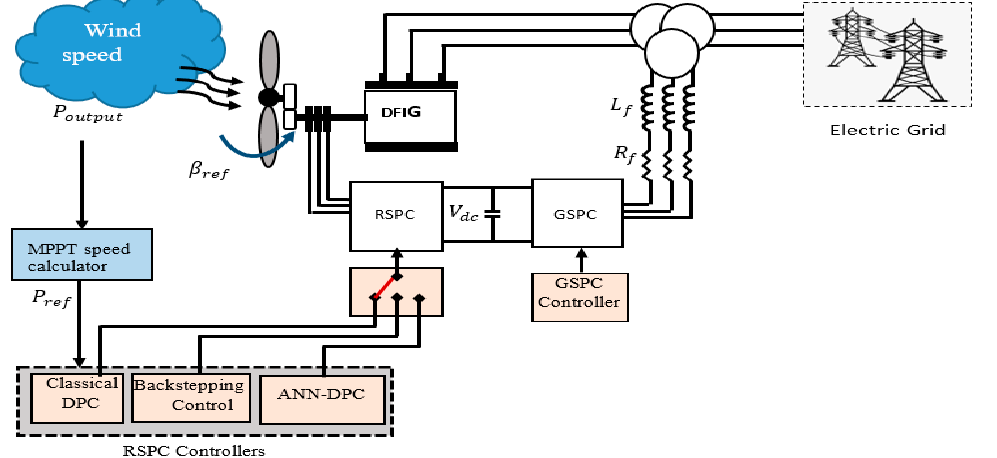
Figure 11. General framework of proposed controllers of DFIG.